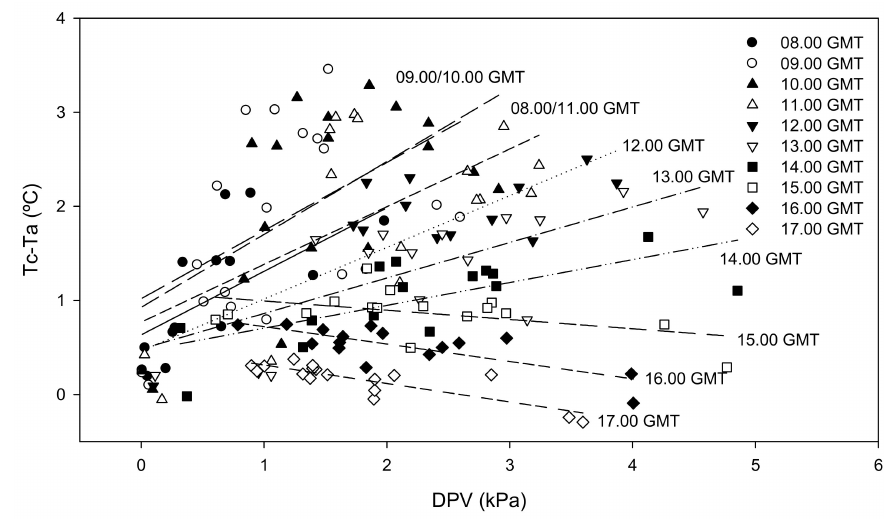
Figure 5. Hourly variation of non-water stress baselines (NWSBs). Relationships between Tc-Ta (C ◦ ) and VPD (kPa) with data from fully irrigated trees (TW-FI) in Period 3 (P3, DOY 240-257) from 08.00-17.00 GMT. Only clear-sky and non-rainy days were used in the calculations. The linear regressions are shown in Table 3.